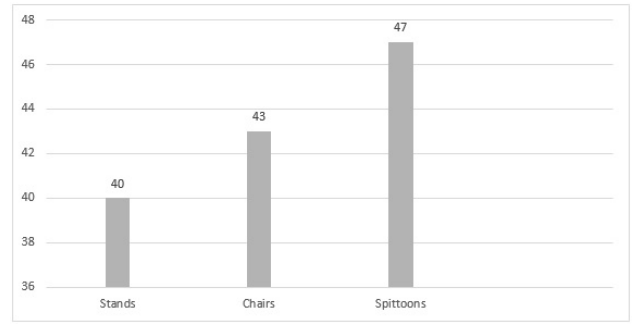
Fig. 3 - Correlation CFU / mL between the sites